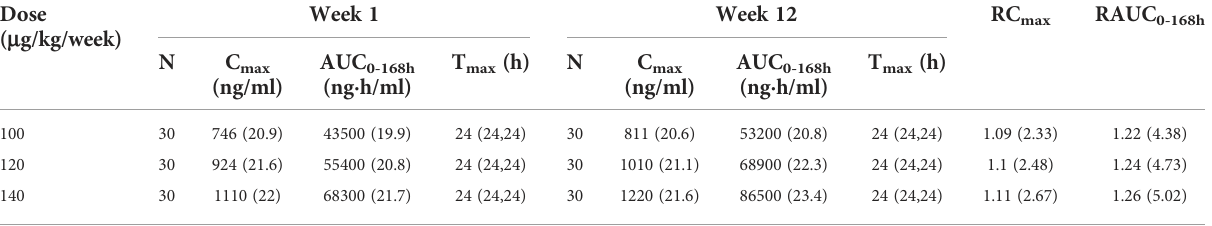
TABLE 1 The model derived PK parameters of YPEG-rhGH.